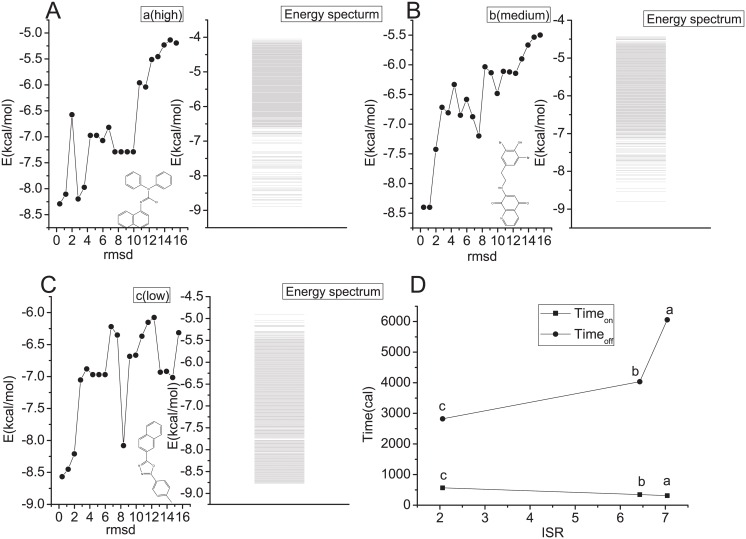
Three representative ligands analyzed in the docking simulations.The left panels of (A), (B) and (C) show the one dimensional projection of binding free energy landscape to RMSD with high, medium and low ISR with similar affinity as well as the corresponding structures of the different ligands, where the docked pose with the most stable affinity or the strongest binding state is chosen as the reference structure to calculate the RMSDs; the Autodock score function is used to evaluate the interaction energies between the ligand and the receptor. (high:fork structure, medium:near-linear structure, low:linear structure);the right panels of them show the corresponding binding energy spectrum for each, the sparse part of the spectrum implies there are fewer states, and dense part of the spectrum implies there are more states. (D) show the kinetic time for binding for the above three different ISRs. The upper black line represents the predicted kinetic timeoff and the under black line represents the predicted kinetic timeon. The vertical axis represents the calculated kinetic time.